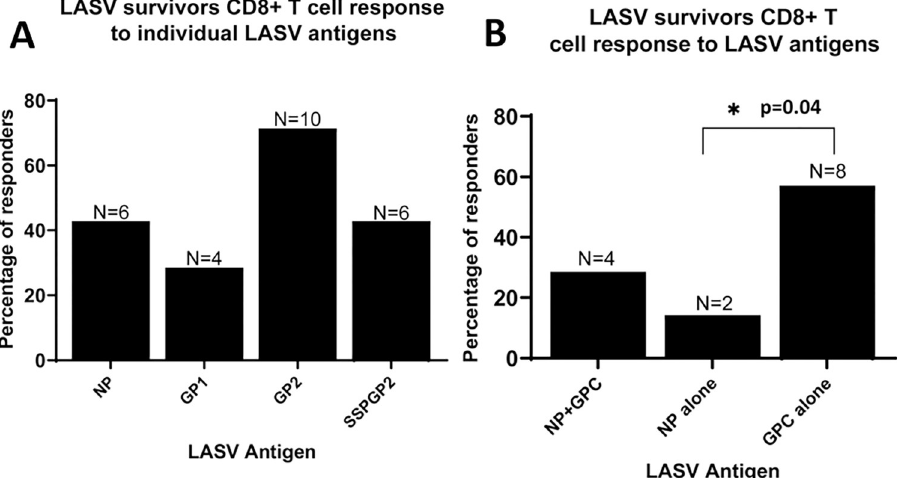
Fig 4. A Frequency of CD8 + T cell response to individual LASV antigens in LF survivors, excluding those that did not respond to the proliferation assay. B Frequency of CD8 + T cell response to either NP + GP, NP alone or GP alone, excluding